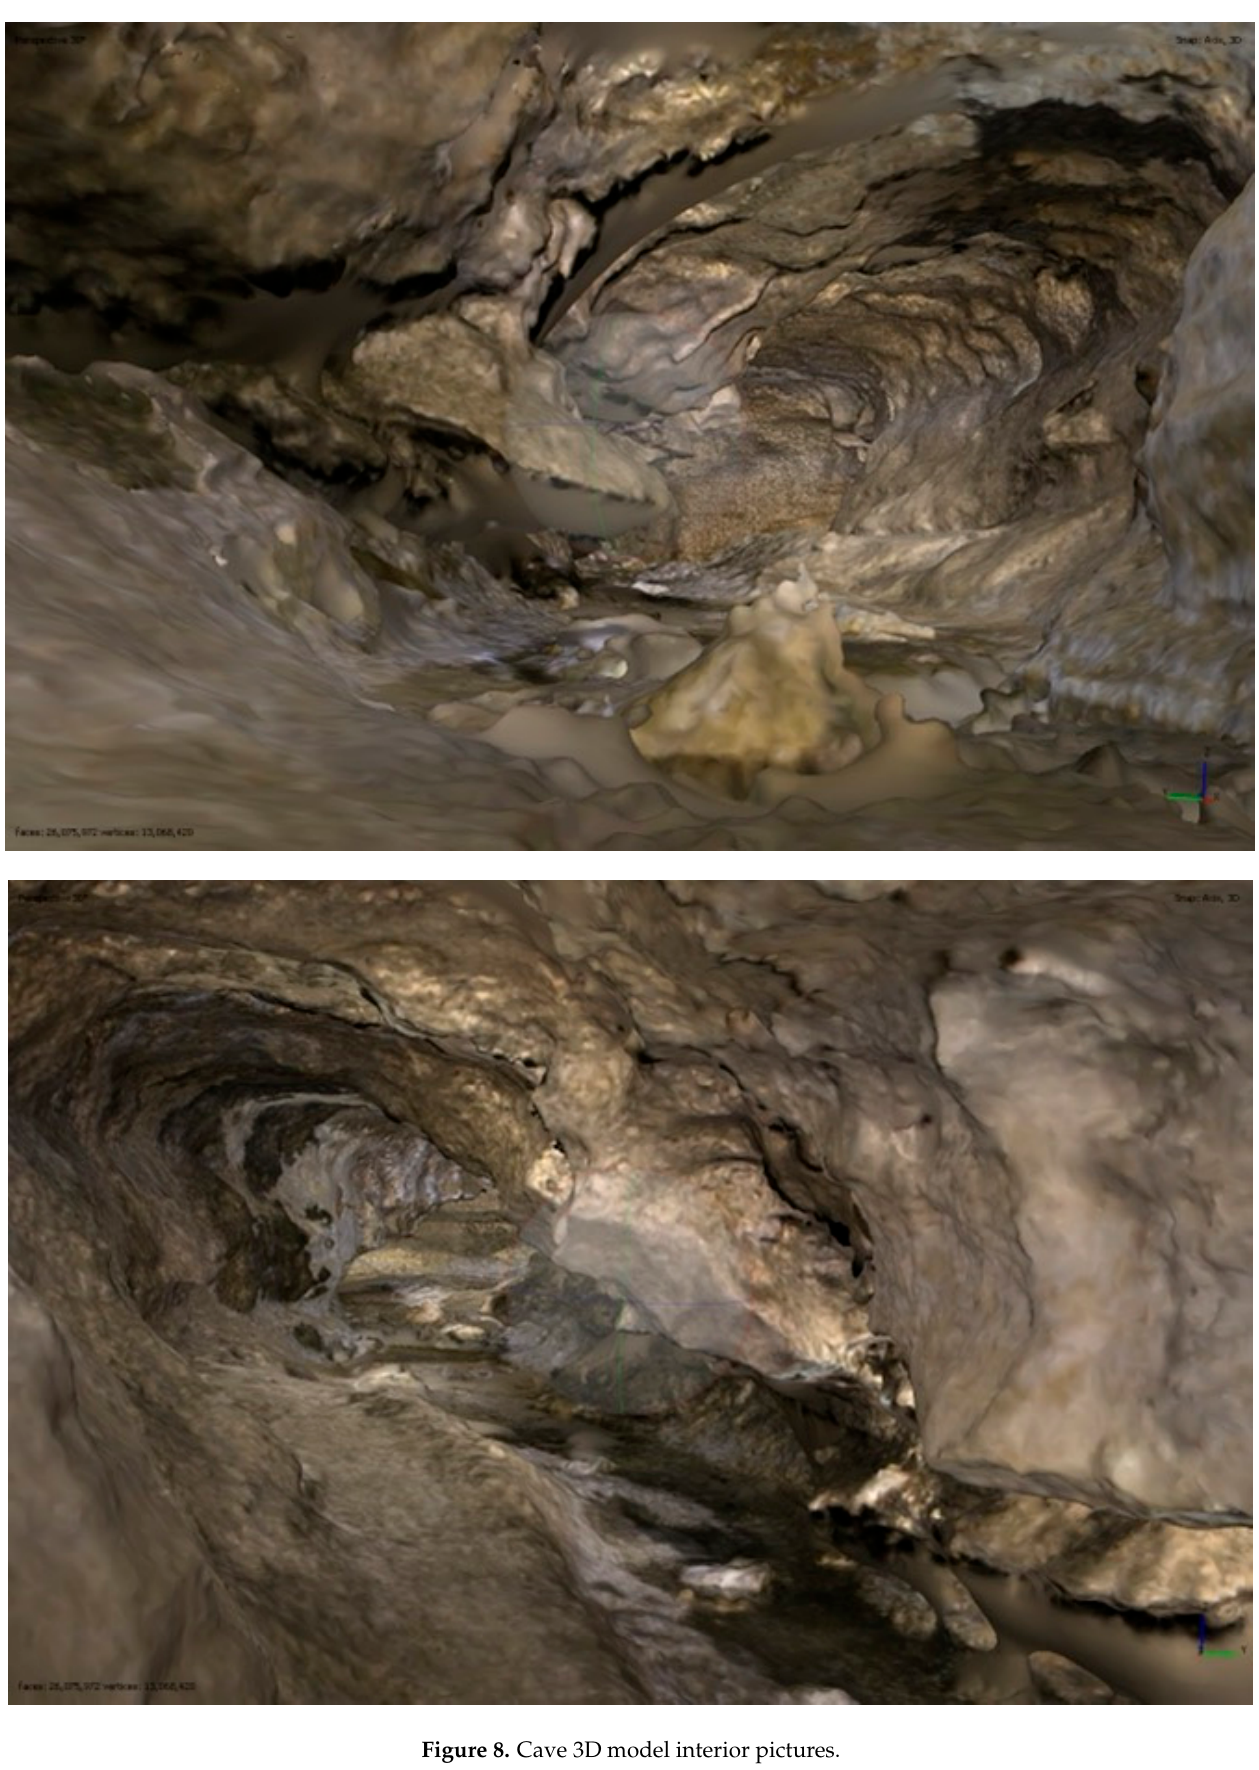
Figure 8. Cave 3D model interior pictures.